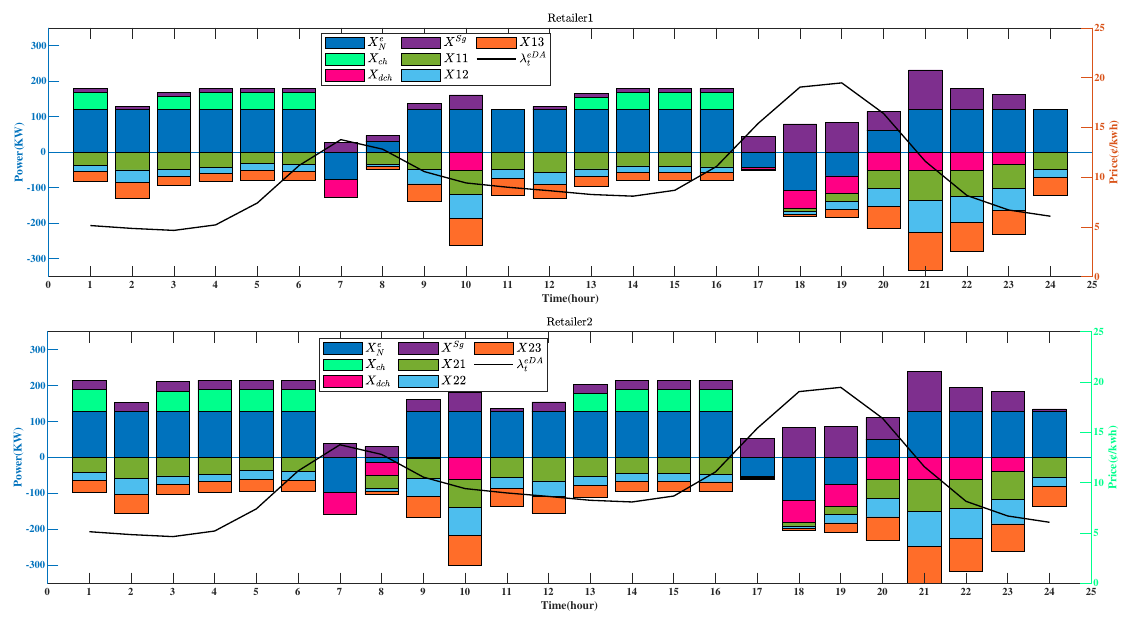
Figure 4. The plot of retailers’ power production from self-generation units, their transactions with the upstream network and prosumers, and the charge and discharge of electrical storage, along with the price variation curve in the deterministic model.